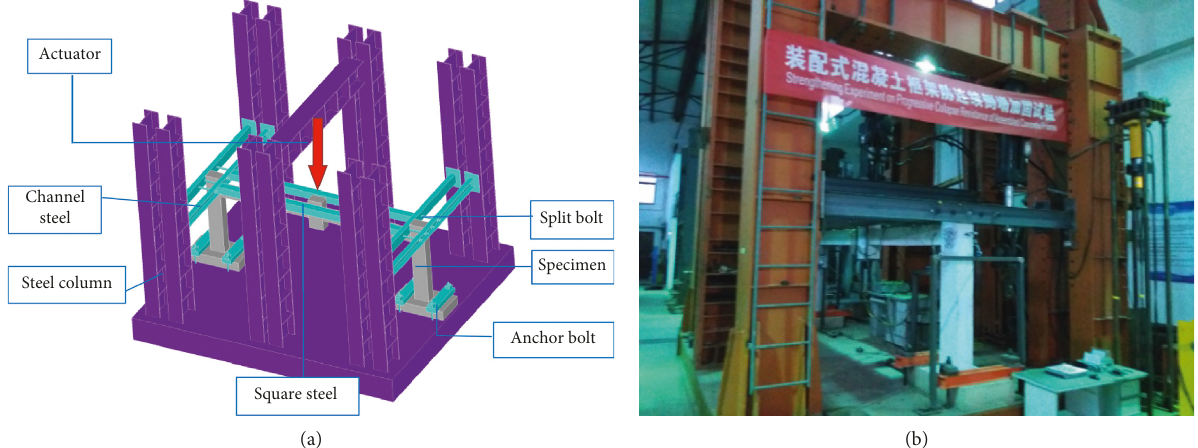
Figure 4: (a) Lateral constraint arrangement. (b) Side view of lateral